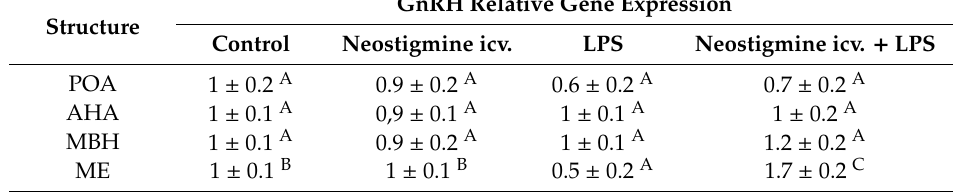
Table 1. E ff ect of lipopolysaccharide (LPS; 400 ng / kg; intravenous) and neostigmine (1 mg / animal;